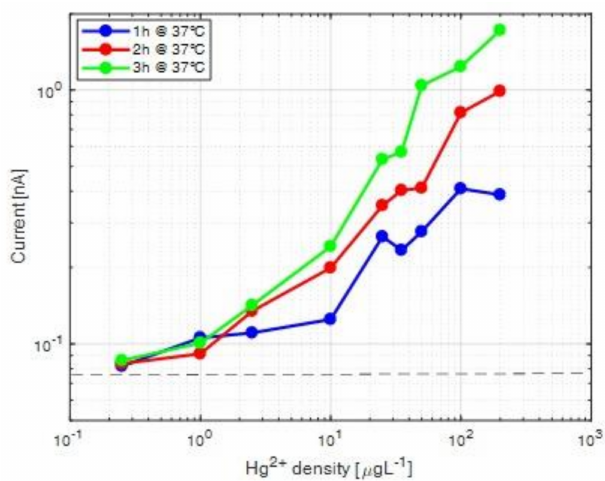
Figure 4. Average bioluminescence signals as a function of Hg 2+ concentration from whole-cell sensor incubations at 1 h (blue line and symbols), 2 h (red line and symbols) or 3 h (green line and symbols). Each point is an average of the first 10 measurement points by the SiPM (as in Figure 3). The Black dashed line corresponds to the dark current.